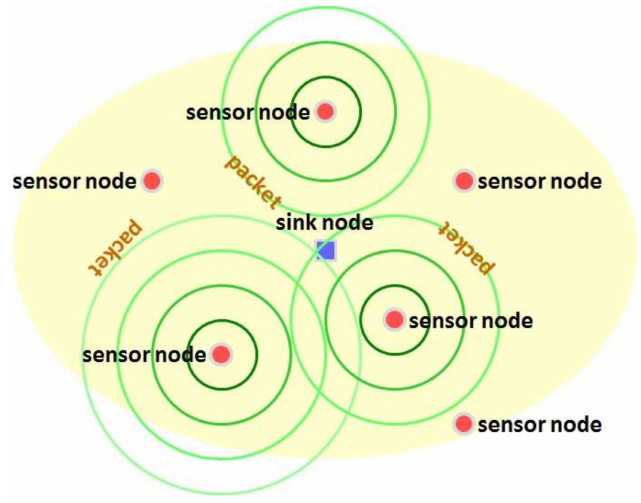
Figure 1. Configuration of RF energy harvesting wireless sensor